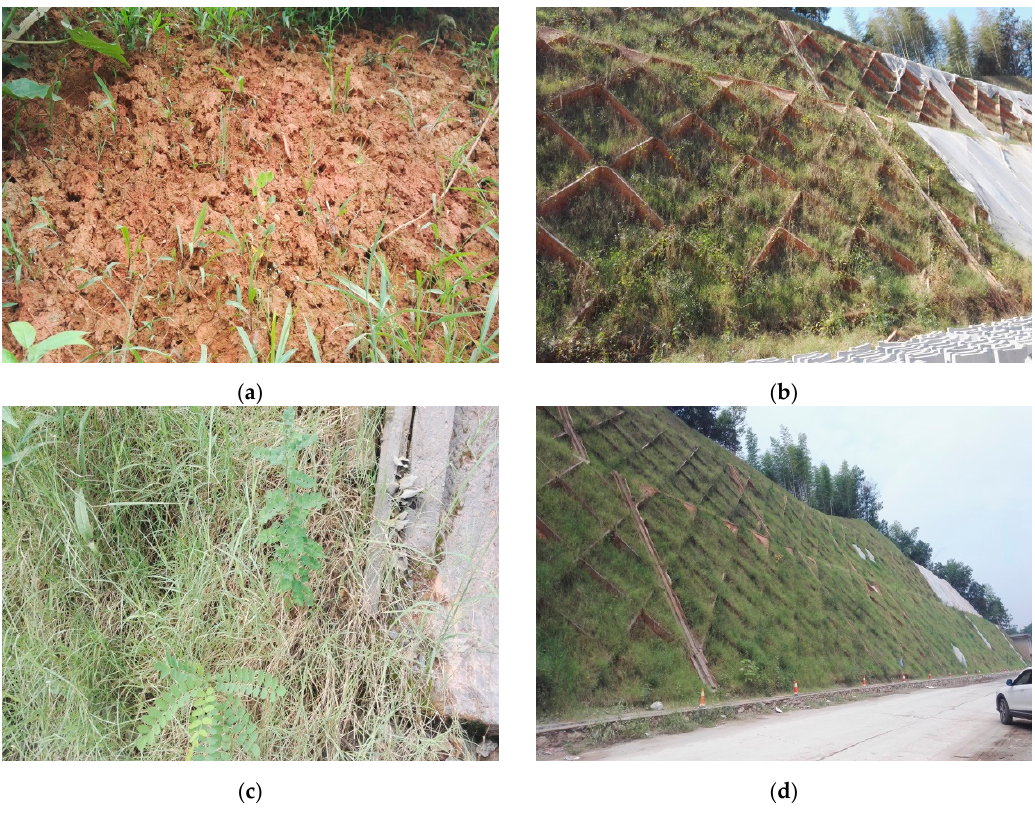
Figure 16. Plant growth condition of the Hunan test slope: ( a ) 1 month later; ( b ) 3 months later; ( c – d ) 6 months later.